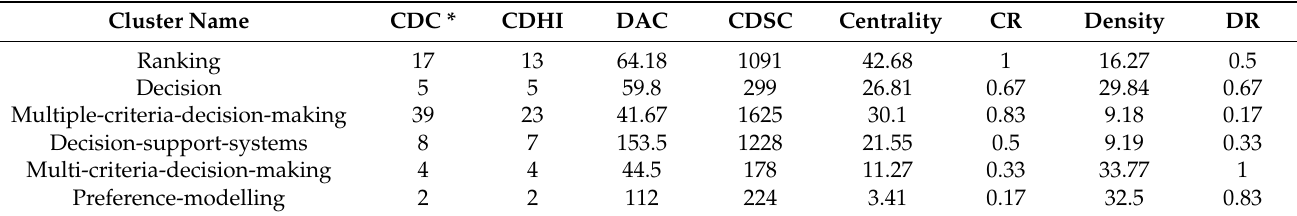
Table 5. Cluster information. Subperiod 1 (1979–2008).